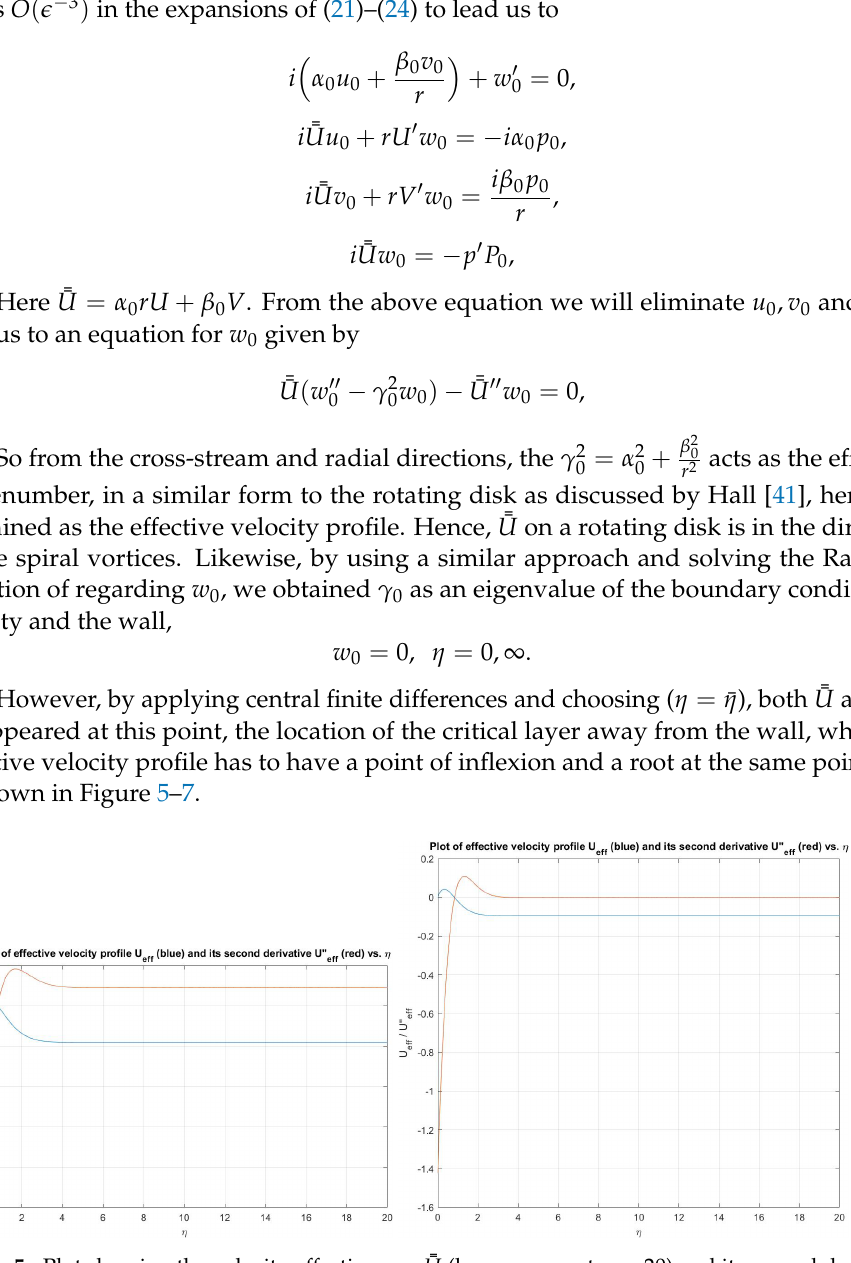
Figure 5. Plot showing the velocity effectiveness ¯¯ U (lower curve at η = 20) and its second derivative ¯¯ U (cid:48)(cid:48) (upper curve at η = 20) for ψ = 90 0 , T s = 0.30 ( left ) and 0.65 ( right